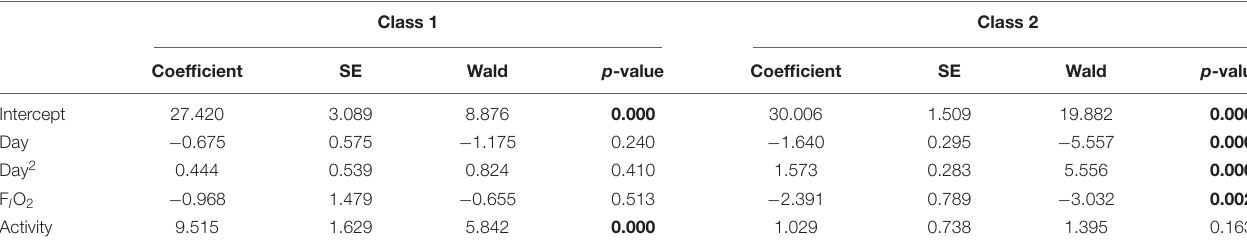
TABLE 6 | The fixed effects in the longitudinal model for PA.